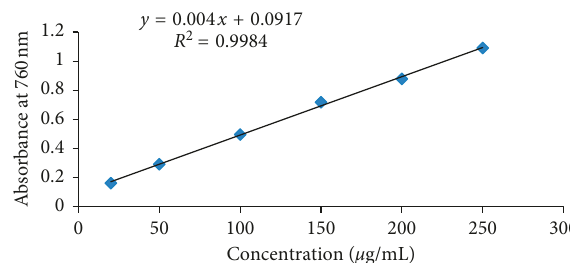
Figure 2: Gallic acid standard curve for the calculation of total polyphenols